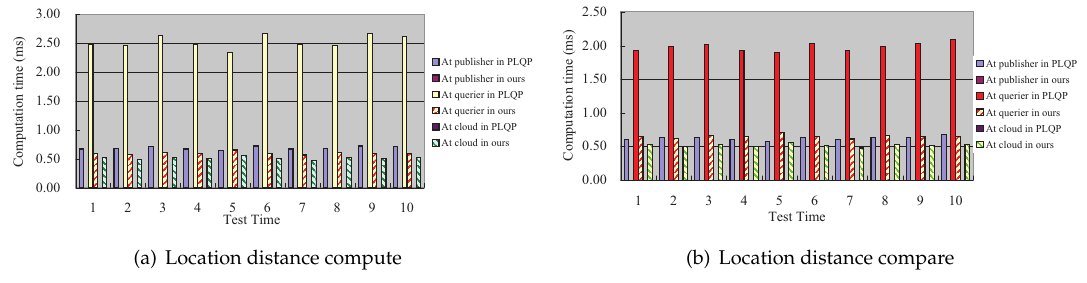
Figure 7. The comparison of each entity’s time cost between our scheme and